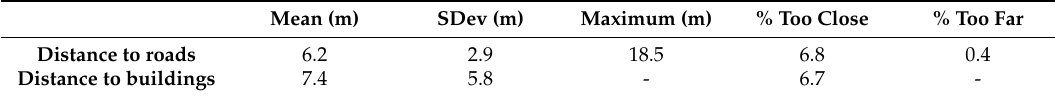
Table 7. Summary of the bus stop locations in relation to buildings and road